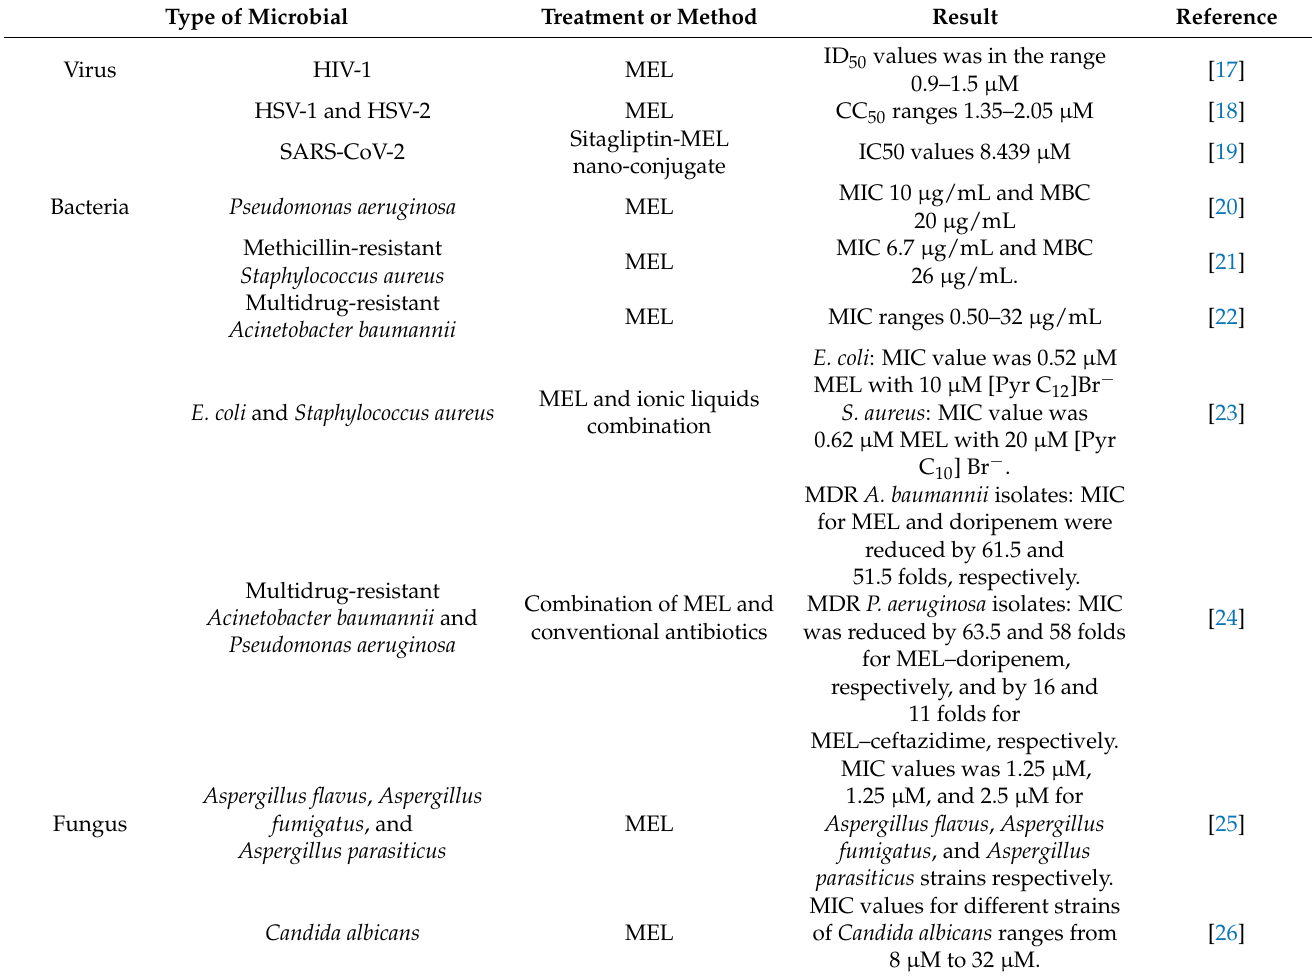
Table 1. In vitro anti-microbial effects of MEL.